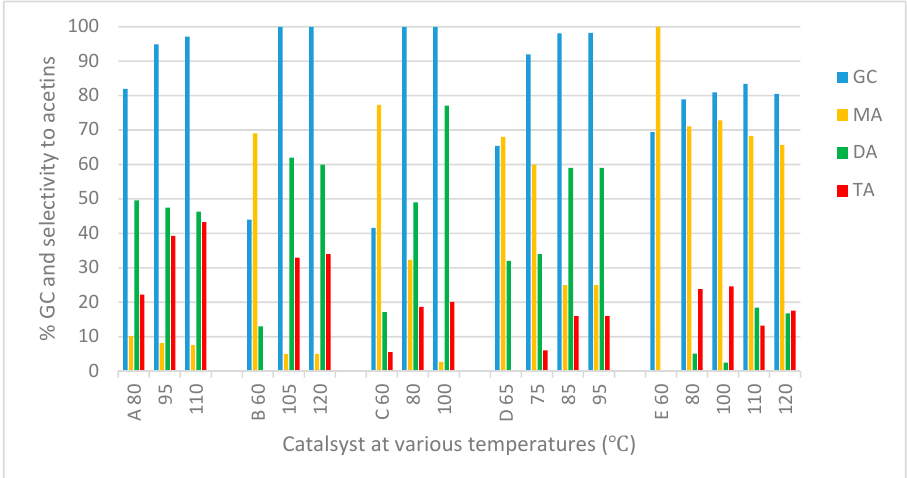
Figure 10. Influence of temperature on glycerol conversion (GC) and selectivity to monoacetin (MA), diacetin (DA) and triacetin (TA) using different catalysts at various reaction conditions (A = amberlyst-15 (Dry), glycerol (G):acetic acid (AAc) 1:9, catalyst load (CL) = 2.645 g, t = 5 h [83]; B = propyl–SO 3 H-functionalized mesoporous silica SBA-15 (SSBA), G:AAc 1:3, CL = 50 mg, t = 3 h [92]; C = SO 42 − / 12ZrKIL-2, G:AAc 1:10, CL = 0.1 g, t = 2 h [105]; D = CsPWA, G:AAc 1:8, CL = 7